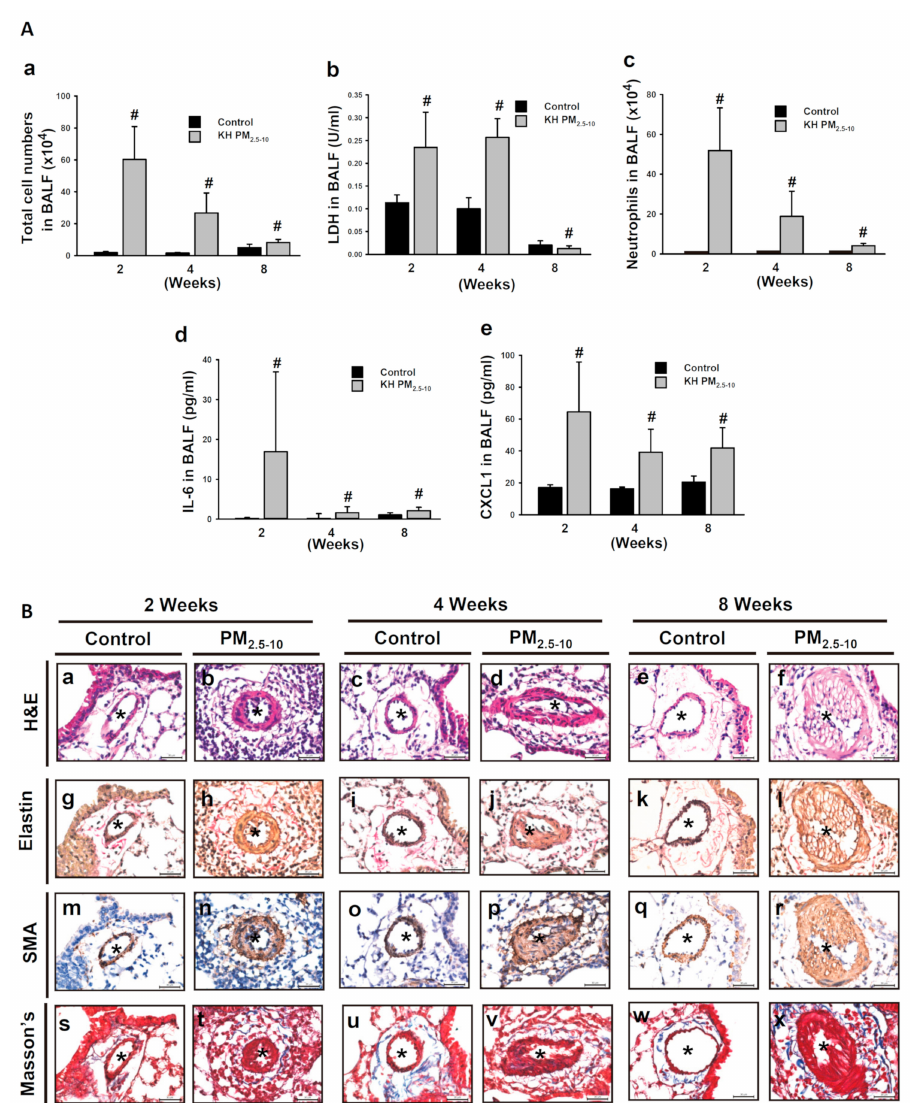
Figure 1. PM 2.5-10 induced pulmonary inflammation and vascular remodeling at 2, 4, and 8 weeks in mouse lungs. ( A ) Each mouse was aspirated with 25 µ g of PM 2.5-10 twice per week for 2, 4, and 8 weeks. ( a ) Total cell numbers, ( b ) LDH activity, ( c ) neutrophil numbers, ( d ) IL-6 protein, and ( e ) CXCL1 protein in BALF were determined. # p < 0.05, compared with respective control-treated mice. ( B ) Each mouse was aspirated with 25 µ g of PM 2.5-10 twice per week for 2, 4, and 8